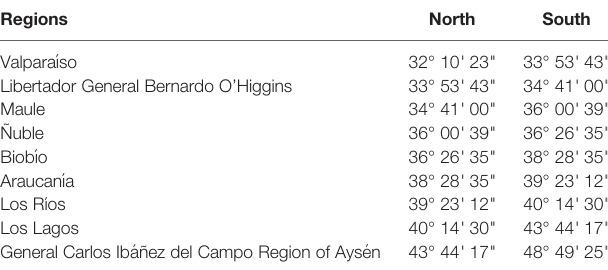
TABLE 2 | Regional coastal limits for catch analysis and industrial and artisan landings. Regions